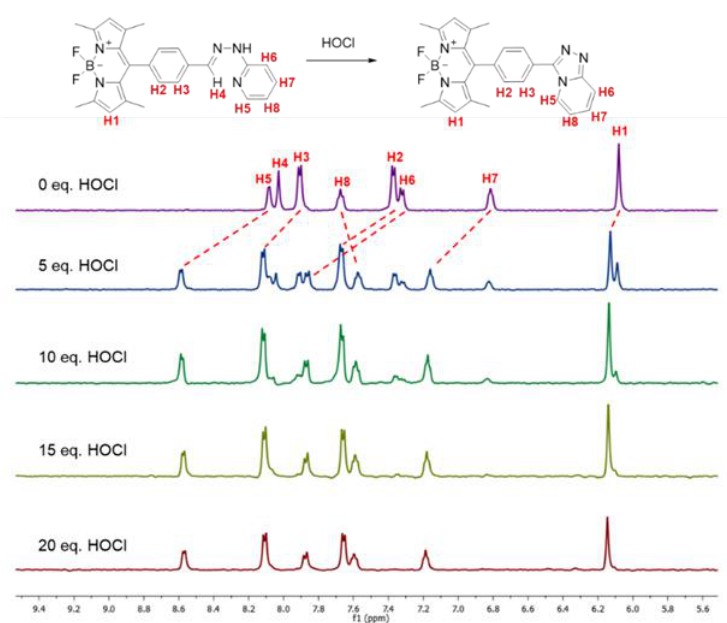
Figure 3. 1 H NMR (500 MHz) spectra of compound 2 in the presence of HOCl in CD 3 OD.